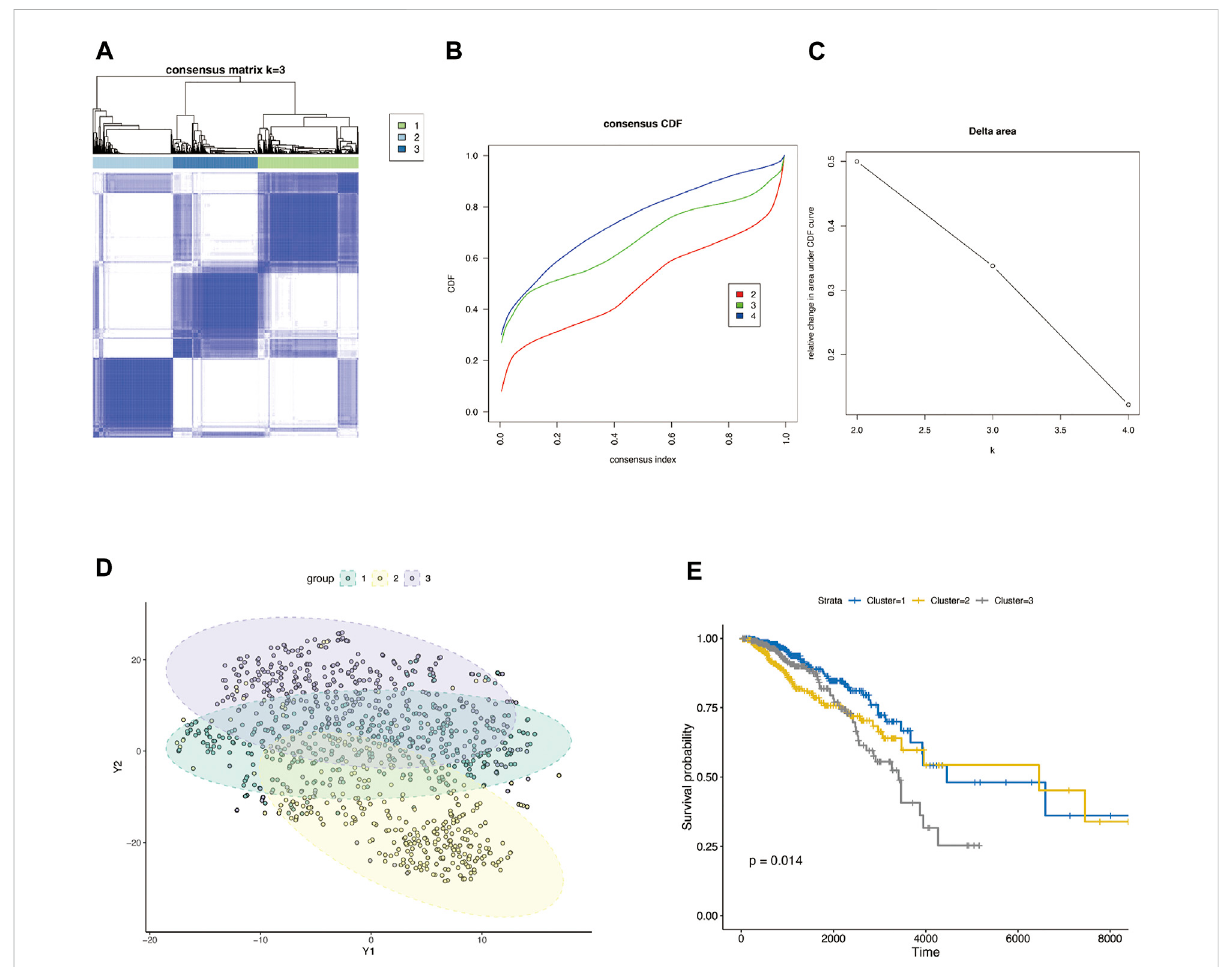
FIGURE 2 Consensus clustering classi fi cation of BRCA based on glycosylation-associated genes. (A) Optimal cluster distinction by consensus matrix (k = 3). (B) Empirical cumulative distribution function (CDF) plot displayed consensus distributions for each k. (C) Delta area plot. (D) T-SNE clustering of sample distributions based on glycosylation-related genes. (E) KM survival analysis of three glycosylation-based